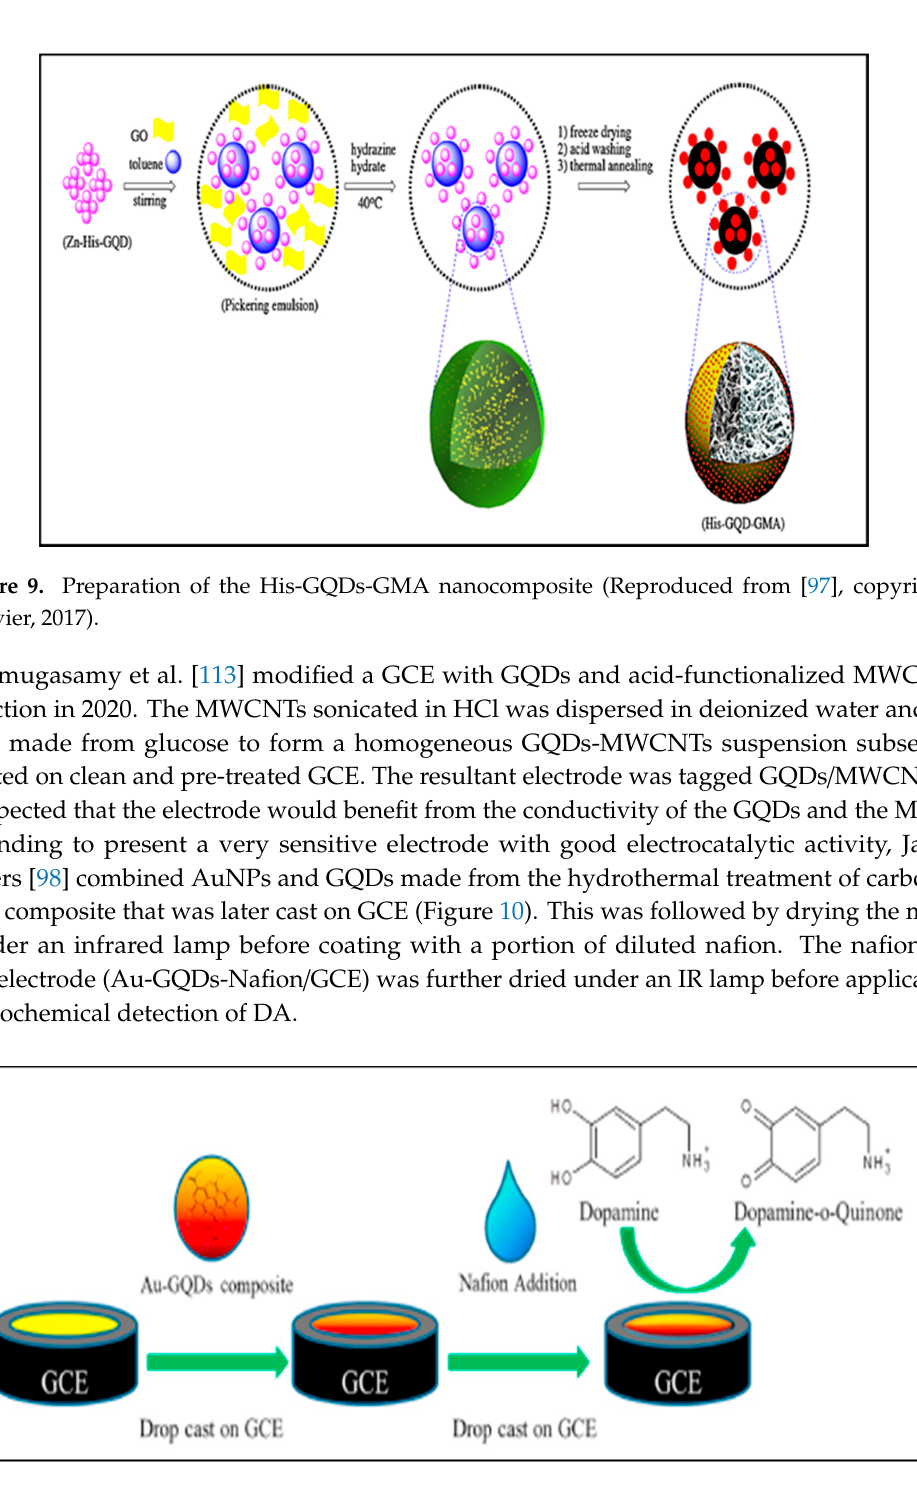
Figure 10. Preparation of Au-GQDS-Nafion-modified electrode for DA detection (Reprinted from [98], copyright Elsevier, 2019).